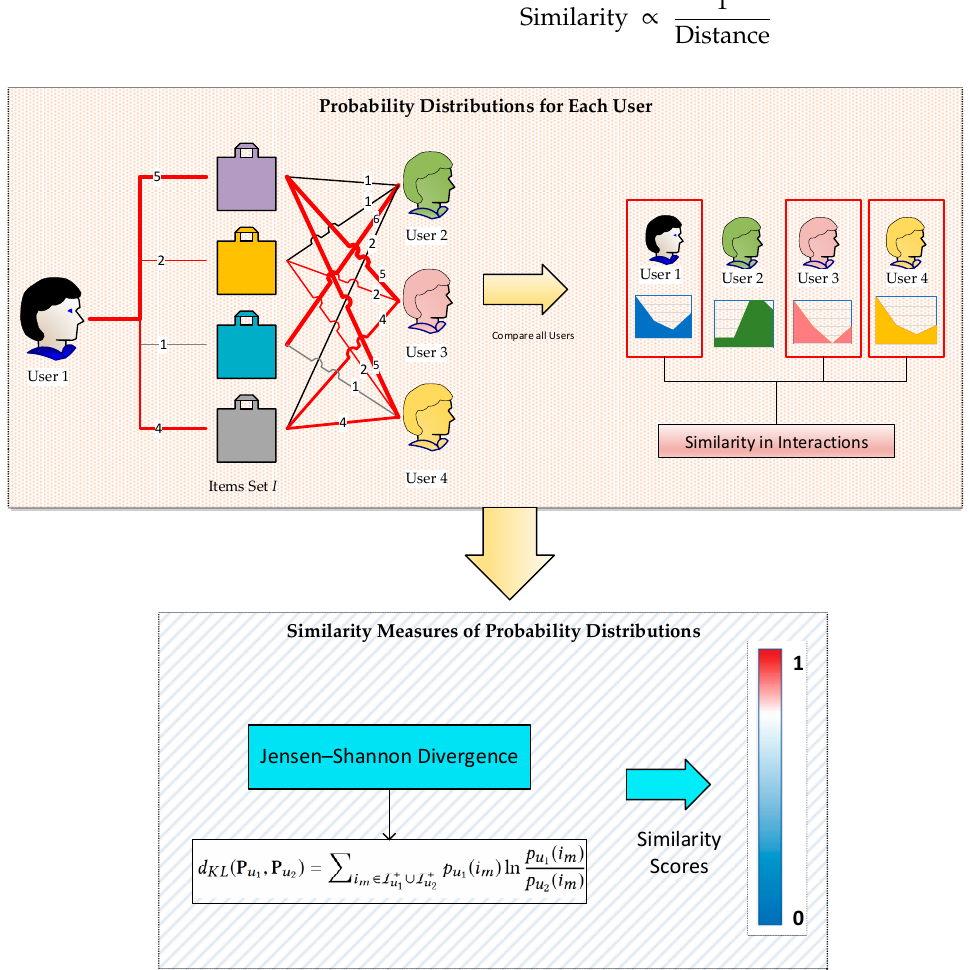
Figure 4. Similarity score estimation for users based on the probability distribution. In terms of the KL divergence, the negative distance between similarities can be ( I ) and P ( I ) , which is defined as the measure defined as the negative distance between P u u j i of similarity between u i and u j as shown in Equation (6).